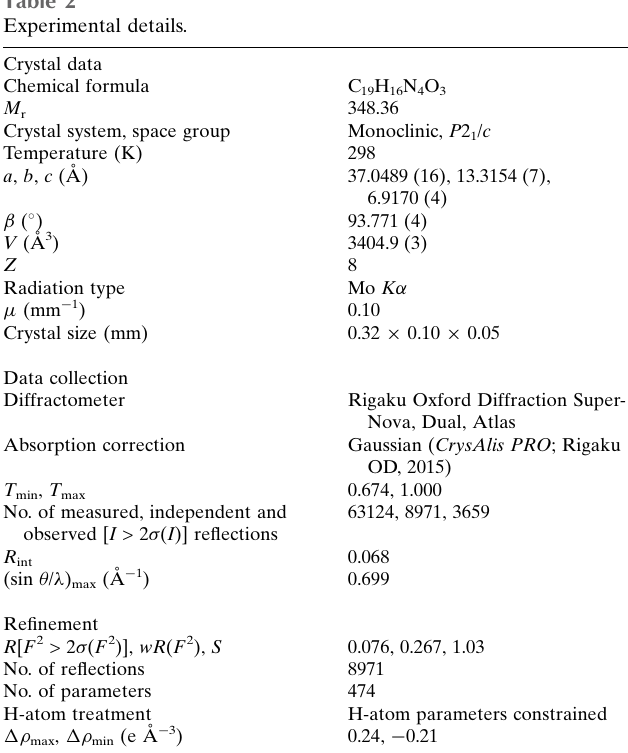
Figure 1 The molecular structure showing 50% probability ellipsoids.